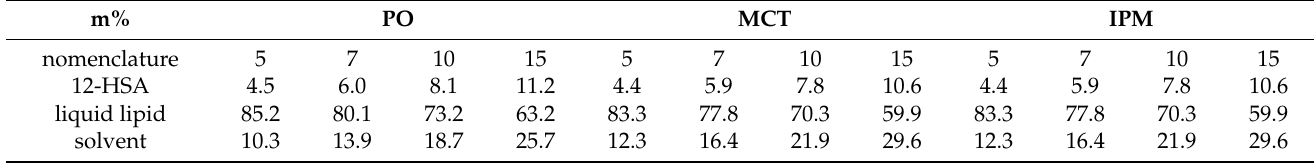
Table 1. The compositions of the formulations selected from the pretests for further